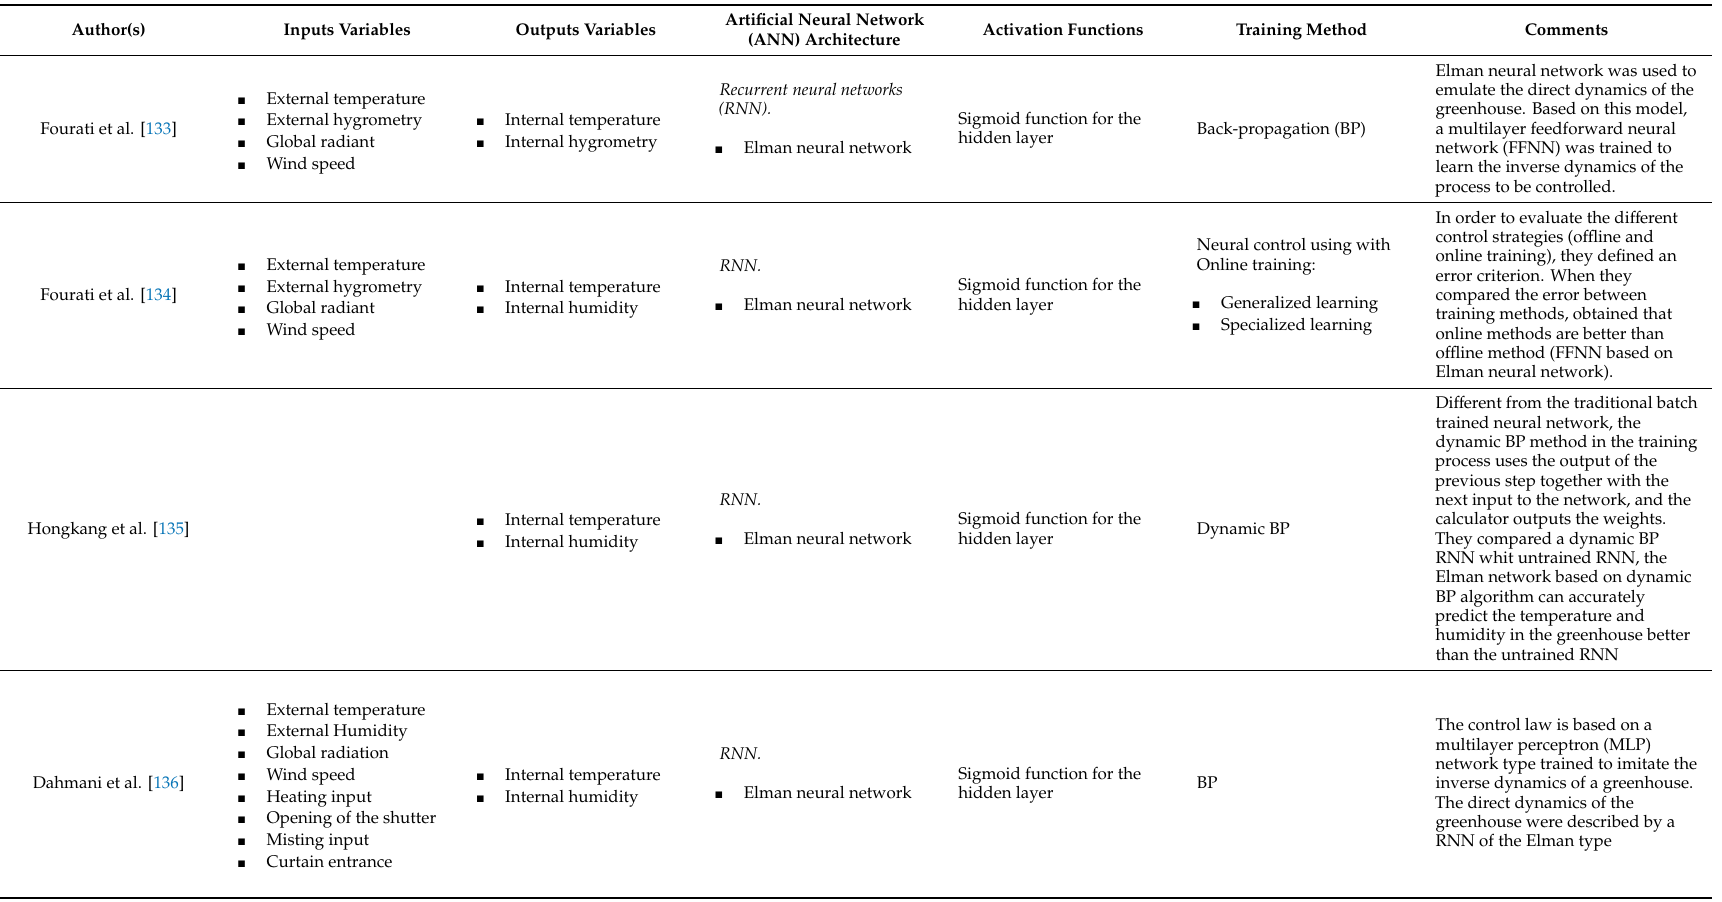
Table 3. Applications of recurrent neural network models for prediction of microclimate in